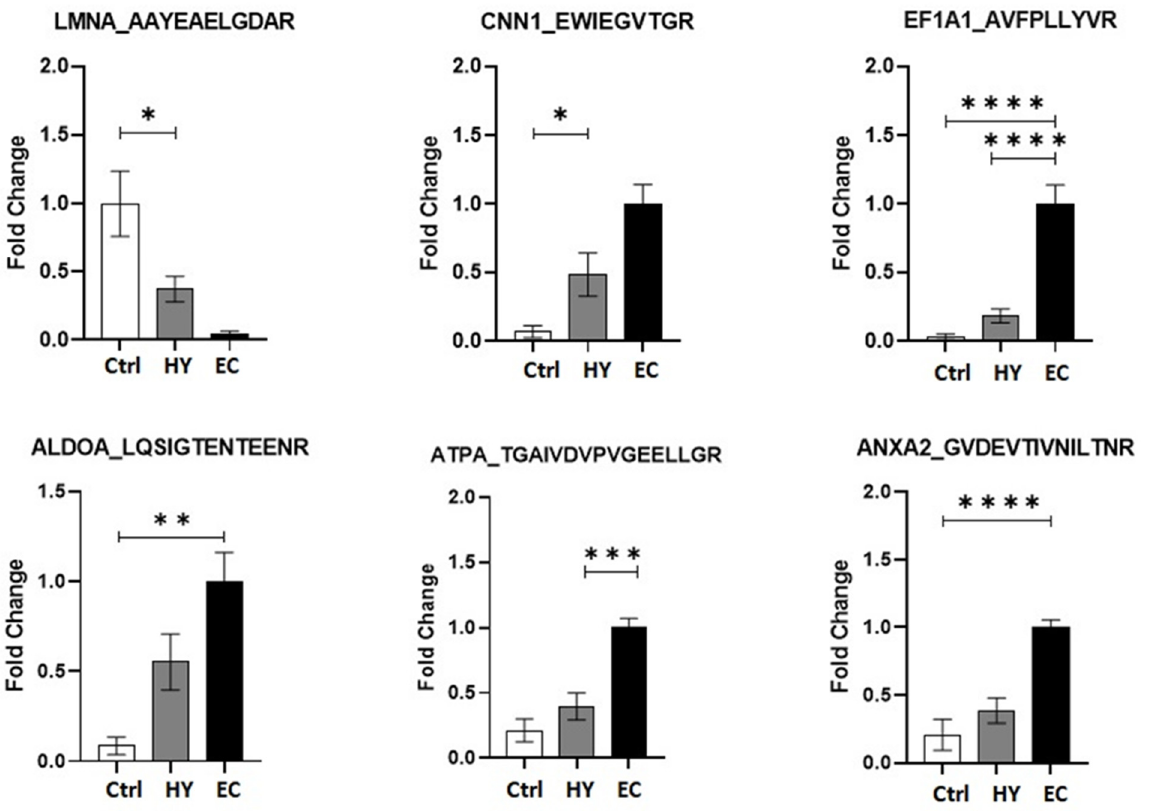
Figure 6. Multiple reaction monitoring (MRM) mass spectrometry for validating study findings. MRM method based on signature peptides was developed to validate the expression of six proteins found in the proteomics approach (2D-DIGE MALDI-TOF-MS). The expression of these six proteins was denoted as fold changes compared among the EC, HY, and Ctrl group. Statistical significance was evaluated using an unpaired t -test ( n = 10), in which * represents p ≤ 0.05, ** represents p ≤ 0.01, *** represents p ≤ 0.001, and **** represents p ≤